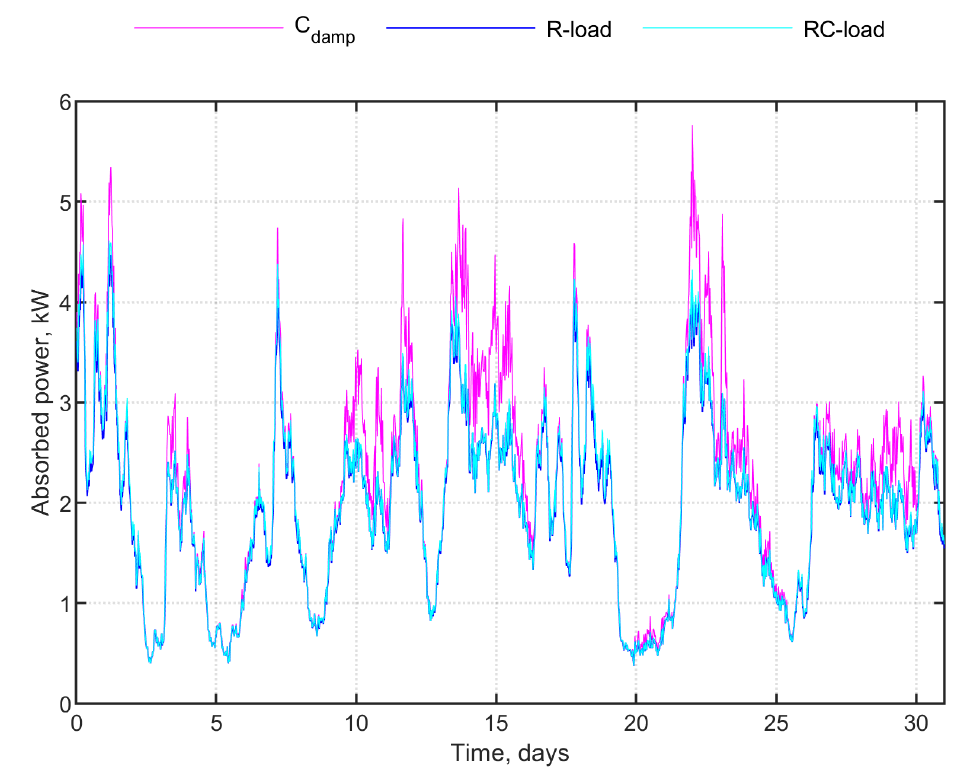
Figure 13. Absorbed power, calculated by c damp , R - and RC -loads for stiff connection. The buoy with a radius of 1 m was